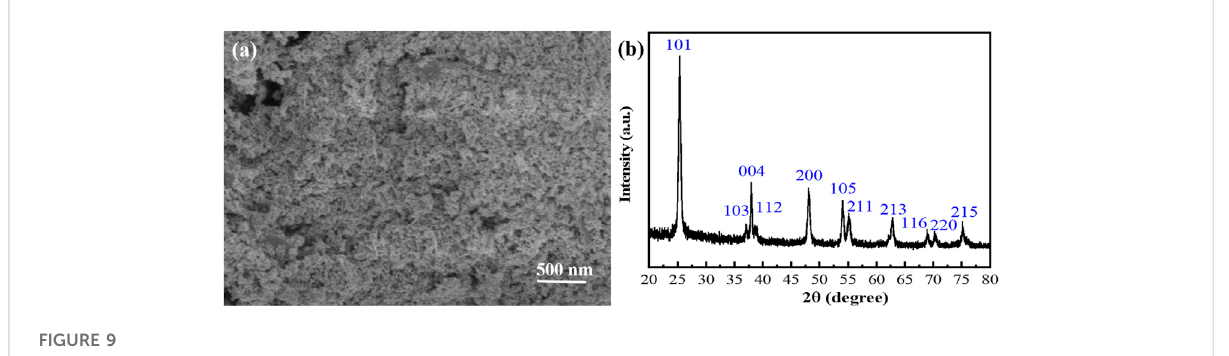
FIGURE 9 SEM image (A) and XRD patterns (B) of Al 2 O 3 and TiO 2